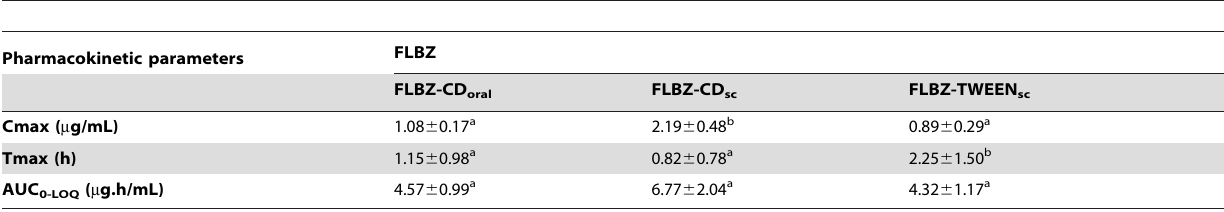
Table 2. Pharmacokinetic parameters (mean 6 SD) obtained for flubendazole (FLBZ) after its administration (5 mg/kg) as different formulations to uninfected jirds: Cyclodextrin-based (FLBZ-CD oral or FLBZ-CD sc ) and Tween-based (FLBZ-TWEEN) formulations.